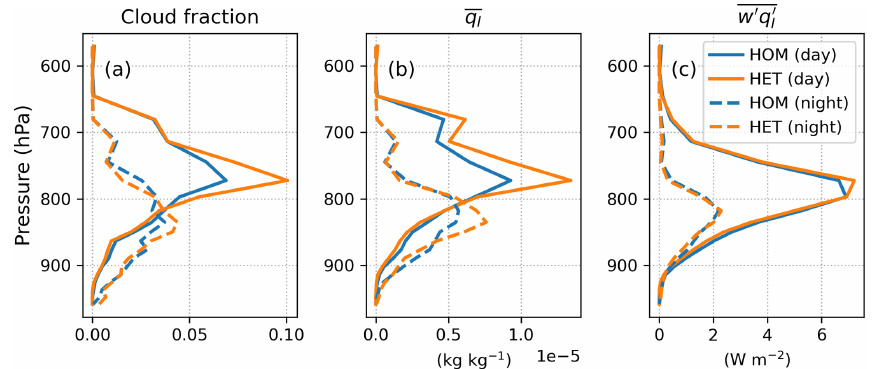
Figure 9. Mean profiles of (a) cloud fraction, (b) cloud liquid water content and (c) liquid water flux averaged during daytime (06:00– 18:00LT in solid lines) and nighttime (18:00–06:00LT in dashed lines), respectively, over the cloudy days in HOM and HET simulations.